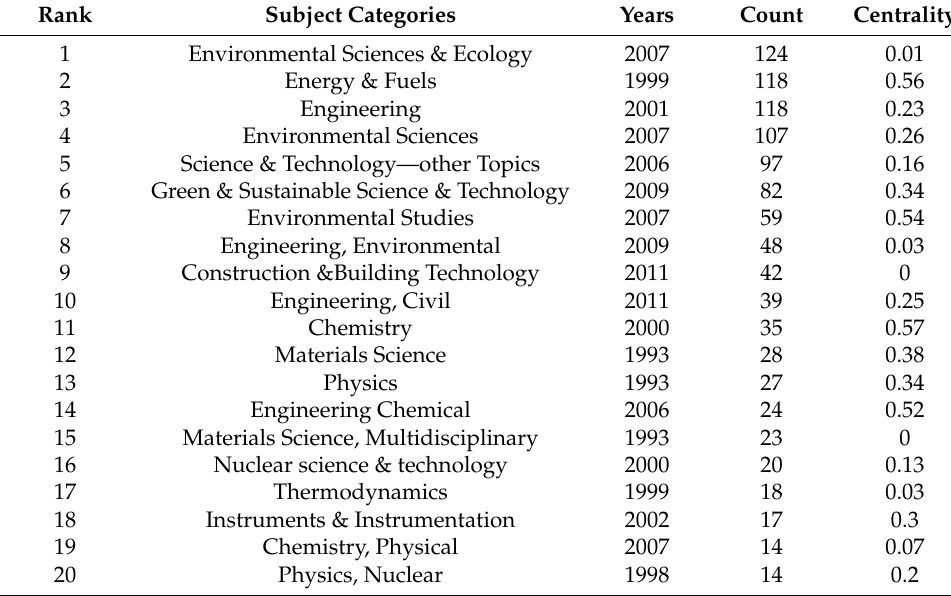
Figure 5. Subject categories involved in CPCN in buildings. Table 5. Top 20 subject categories with the most publications on CPCN in buildings.